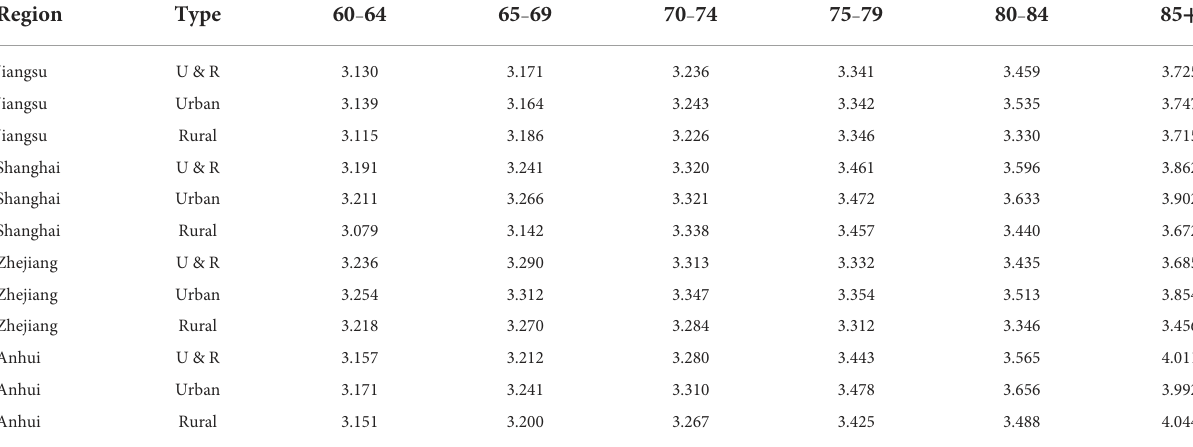
TABLE 3 Aged healthcare composite index for Jiangsu, Shanghai, Zhejiang and